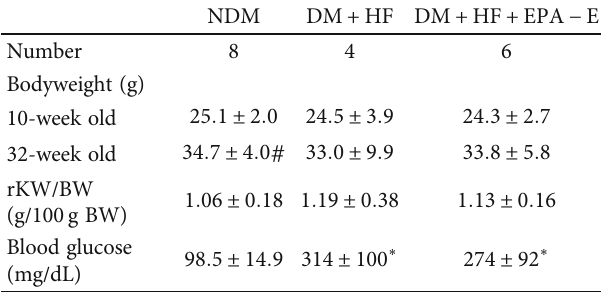
Table 1: General characteristics of the experimental groups.